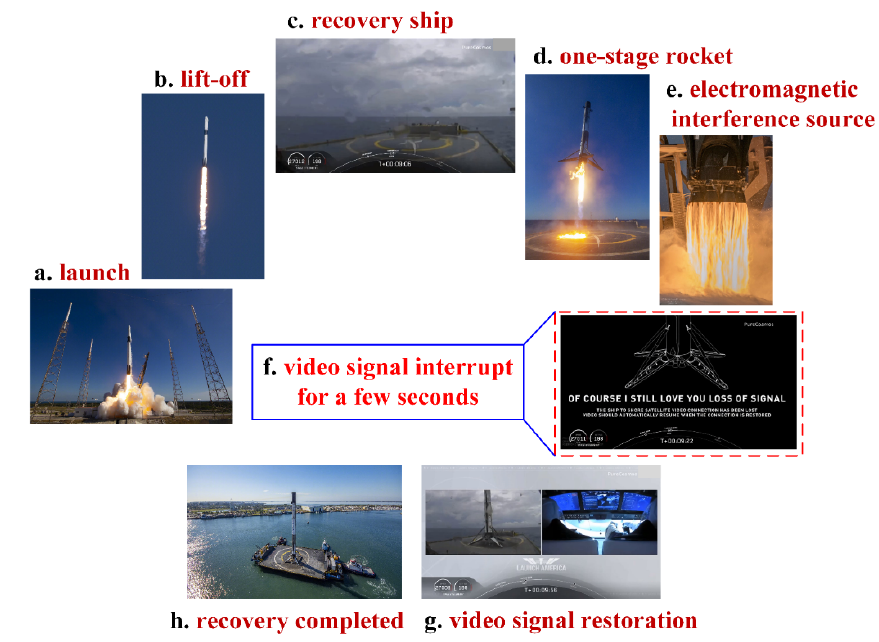
Figure 1. Recovery process of the first-stage rocket of a Falcon 9.